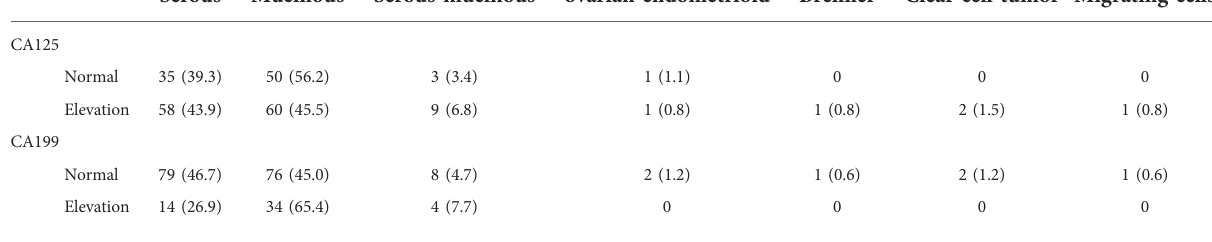
TABLE 3 The changes of CA125 and CA199 in patients with borderline ovarian